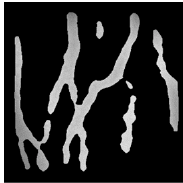
Figure 6. The gray image that only retains the contour of dorsal hand vein.